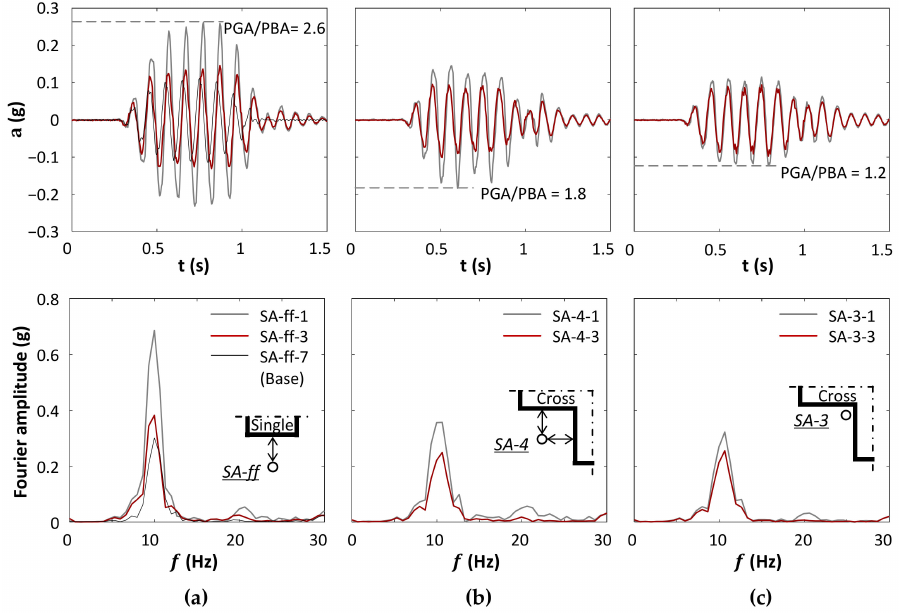
Figure 9. Time histories of the soil accelerations recorded during sinusoidal excitation, with a dominant frequency of 10 Hz in ( a ) the SA-ff array at the elevation of the base, bottom and top slab of the two-story structure, ( b ) the SA-4 array and ( c ) the SA-3 array at the elevation of the bottom and top slab of the two-story